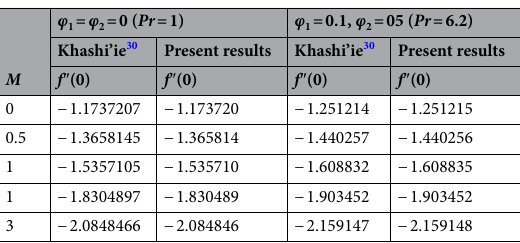
Table 3. The comparative values of f ″ (0) for several values of magnetic parameter M when S viscous fluid and hybrid